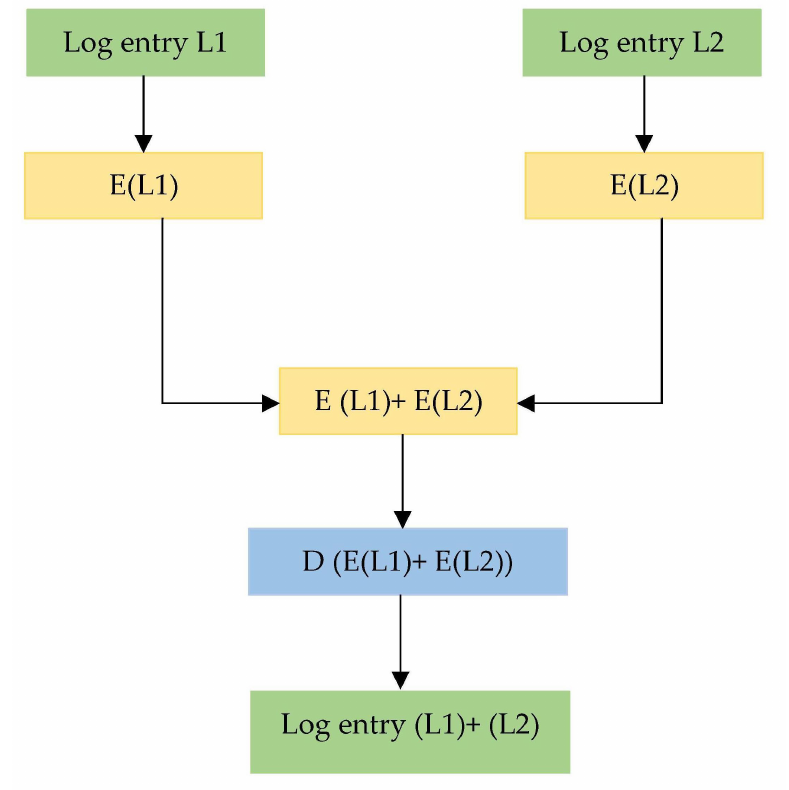
Figure 13. Paillier Homomorphic Encryption (PHE) mechanism in cloud